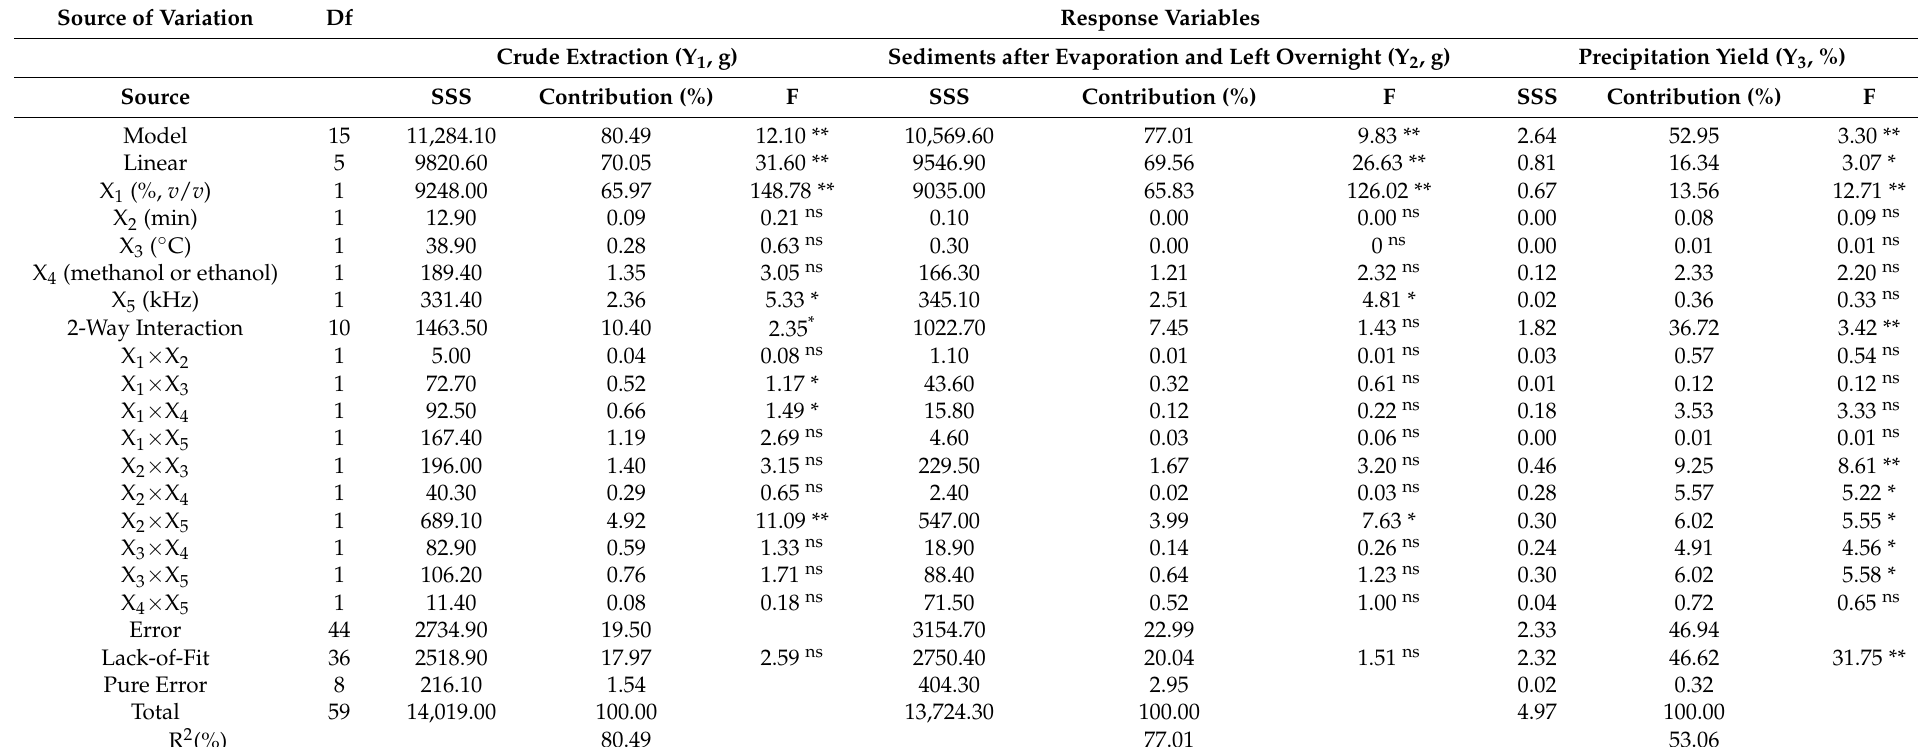
Table 1. Regression coefficients and analysis of variance of the regression models for extraction